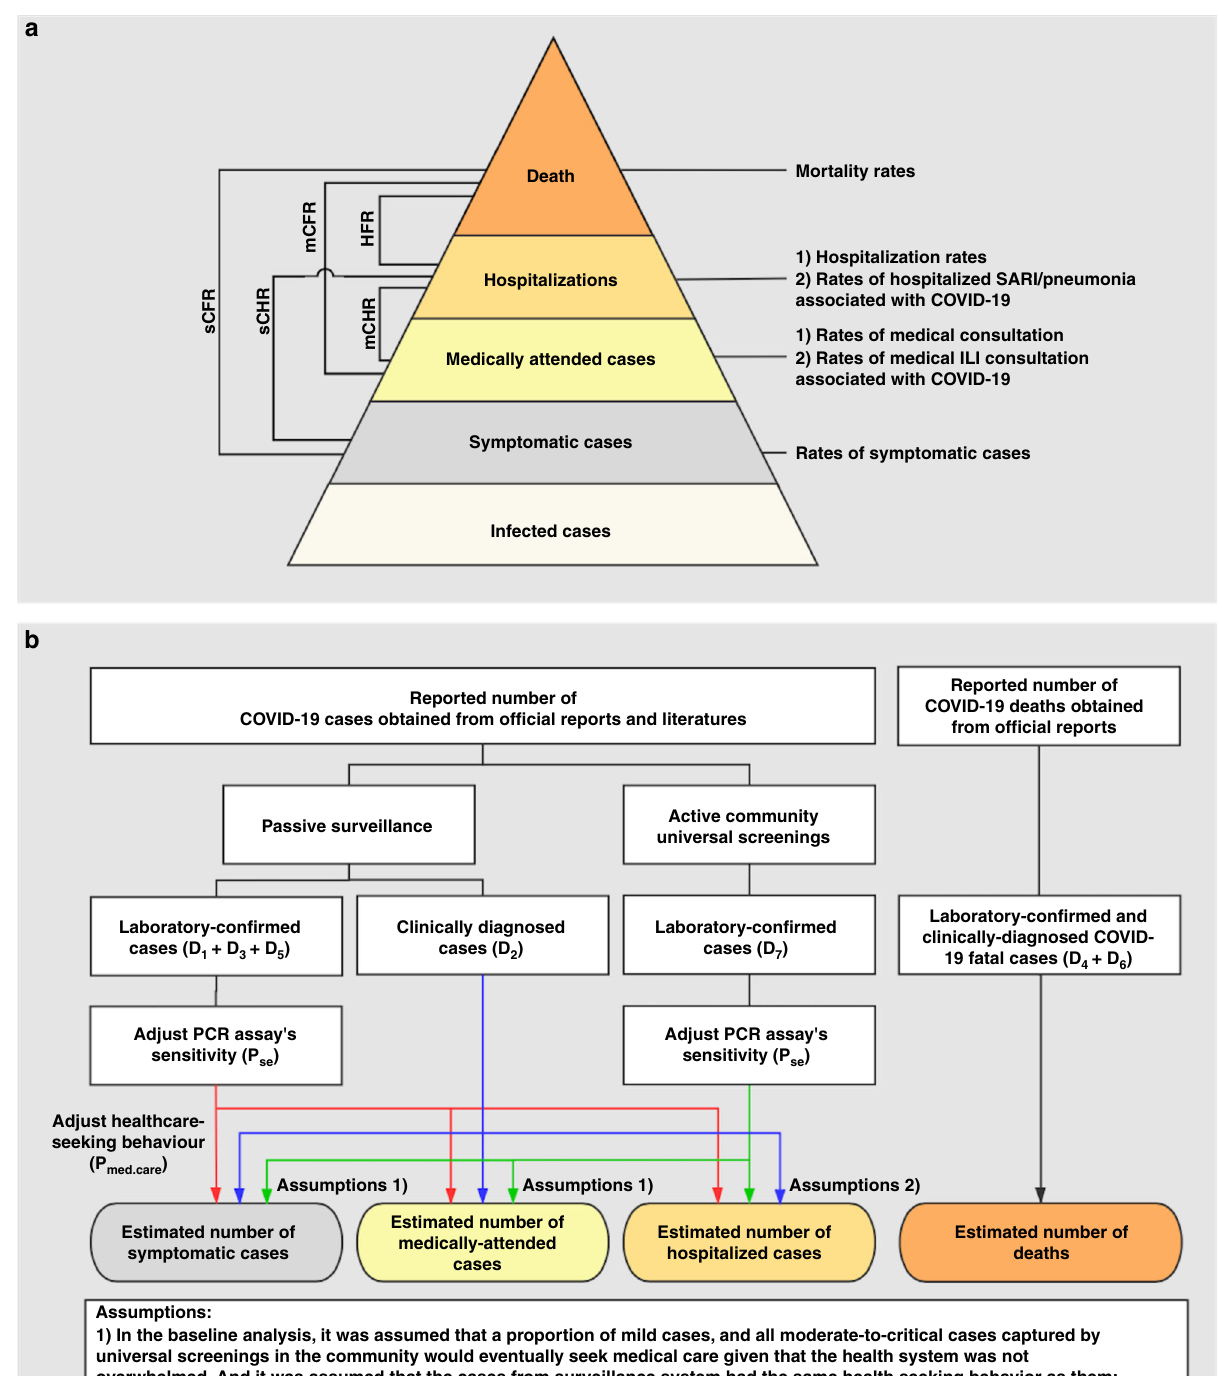
Fig. 1 Severity levels of COVID-19 and schematic diagram of the baseline analyses. a Severity levels of infections with SARS-CoV-2 and parameters of interest. Each level is assumed to be a subset of the level below. sCFR symptomatic case-fatality risk, sCHR symptomatic case-hospitalization risk, mCFR medically attended case-fatality risk, mCHR medically attended case-hospitalization risk, HFR hospitalization-fatality risk. b Schematic diagram of the baseline analyses. Data source of COVID-19 cases in Wuhan: D1) 32,583 laboratory-con fi rmed COVID-19 cases as of March 8 4 , D2) 17,365 clinically- diagnosed COVID-19 cases during February 9 – 19 4 , D3)daily number of laboratory-con fi rmed cases on March 9 – April 24 3 , D4) total number of COVID-19 deaths as of April 24 obtained from the Hubei Health Commission 3 , D5) 325 laboratory-con fi rmed cases and D6) 1290 deaths were added as of April 16 through a comprehensive and systematic veri fi cation by Wuhan Authorities 3 , and D7) 16,781 laboratory-con fi rmed cases identi fi ed through universal screening 10,11 . P se : RT-PCR sensitivity 12 . P med.care : proportion of seeking medical assistance among patients suffering from acute respiratory infections 13 . (Red, blue, and green arrows separately denote the data fl ow from laboratory-con fi rmed cases of passive surveillance, clinically-diagnosed cases, and laboratory-con fi rmed cases of active